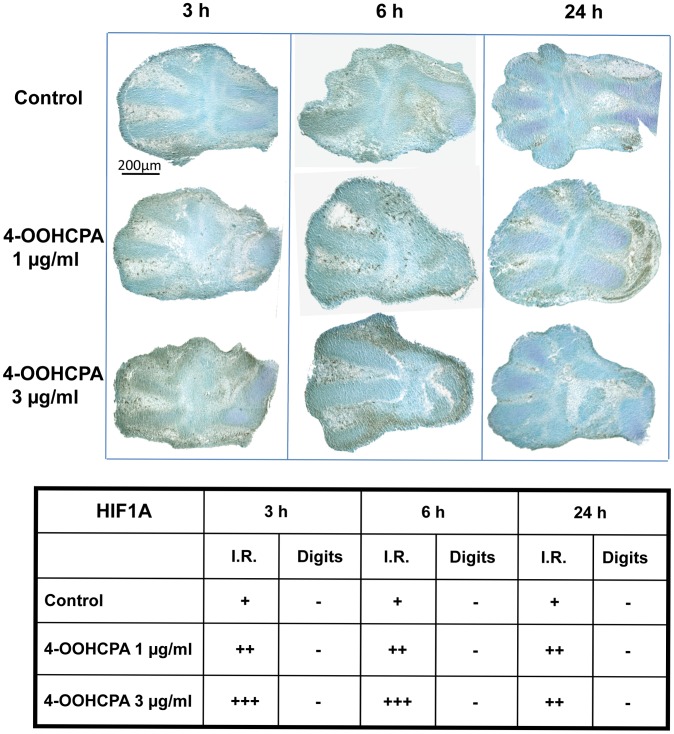
Immunolocalization of HIF1A in limbs.Immunoreactivity was detected in control limbs in the apical ectodermal ridge and interdigital regions (I.R.). The mesenchymal condensations/developing cartilaginous anlagen (Digits) were not immunoreactive. 4-OOHCPA treatment resulted in a concentration- and time-dependent increase in HIF1A immunoreactivity in this area in the 3 and 6 h exposure groups; staining was diminished by 24 h. Four separate replicates were done.